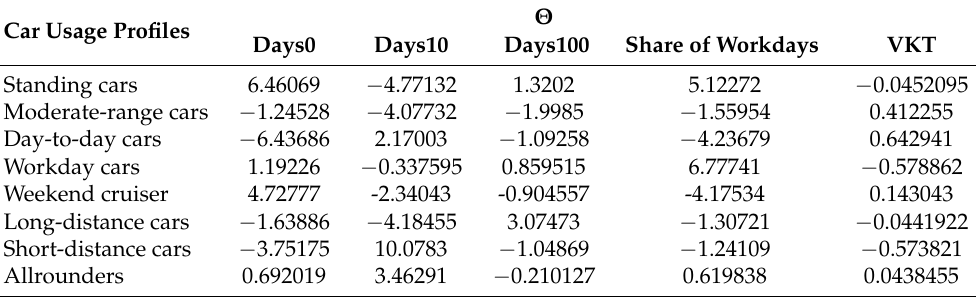
Table 2. Decision functions for the respective car usage